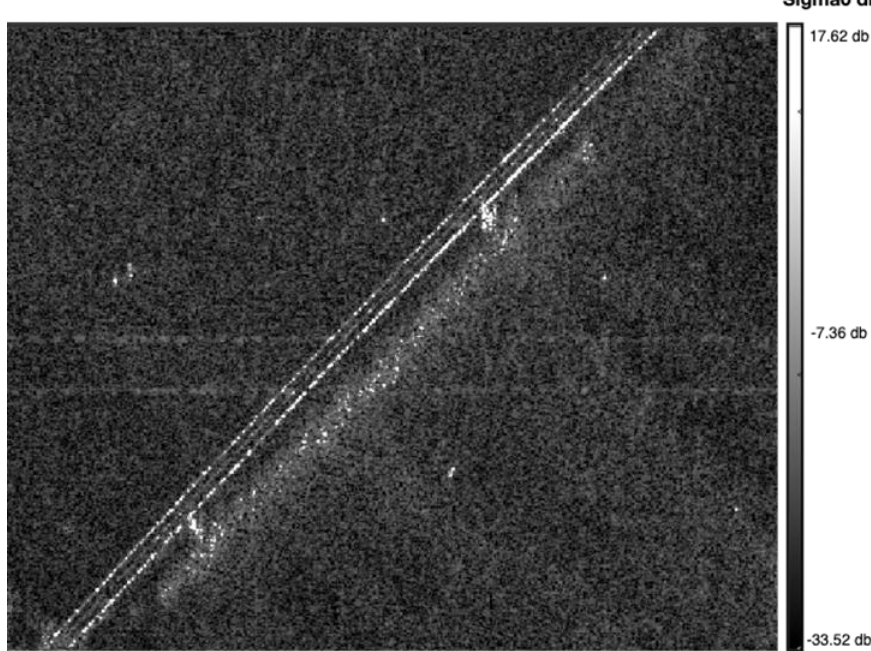
Figure 7. Backscatter intensity at Baishazhou Bridge, from COSMO-SkyMed StripMap HIMAGE SAR scene acquired on 13 July 2016. COSMO-SkyMed ® Products © ASI—Italian Space Agency—2016. All rights reserved.